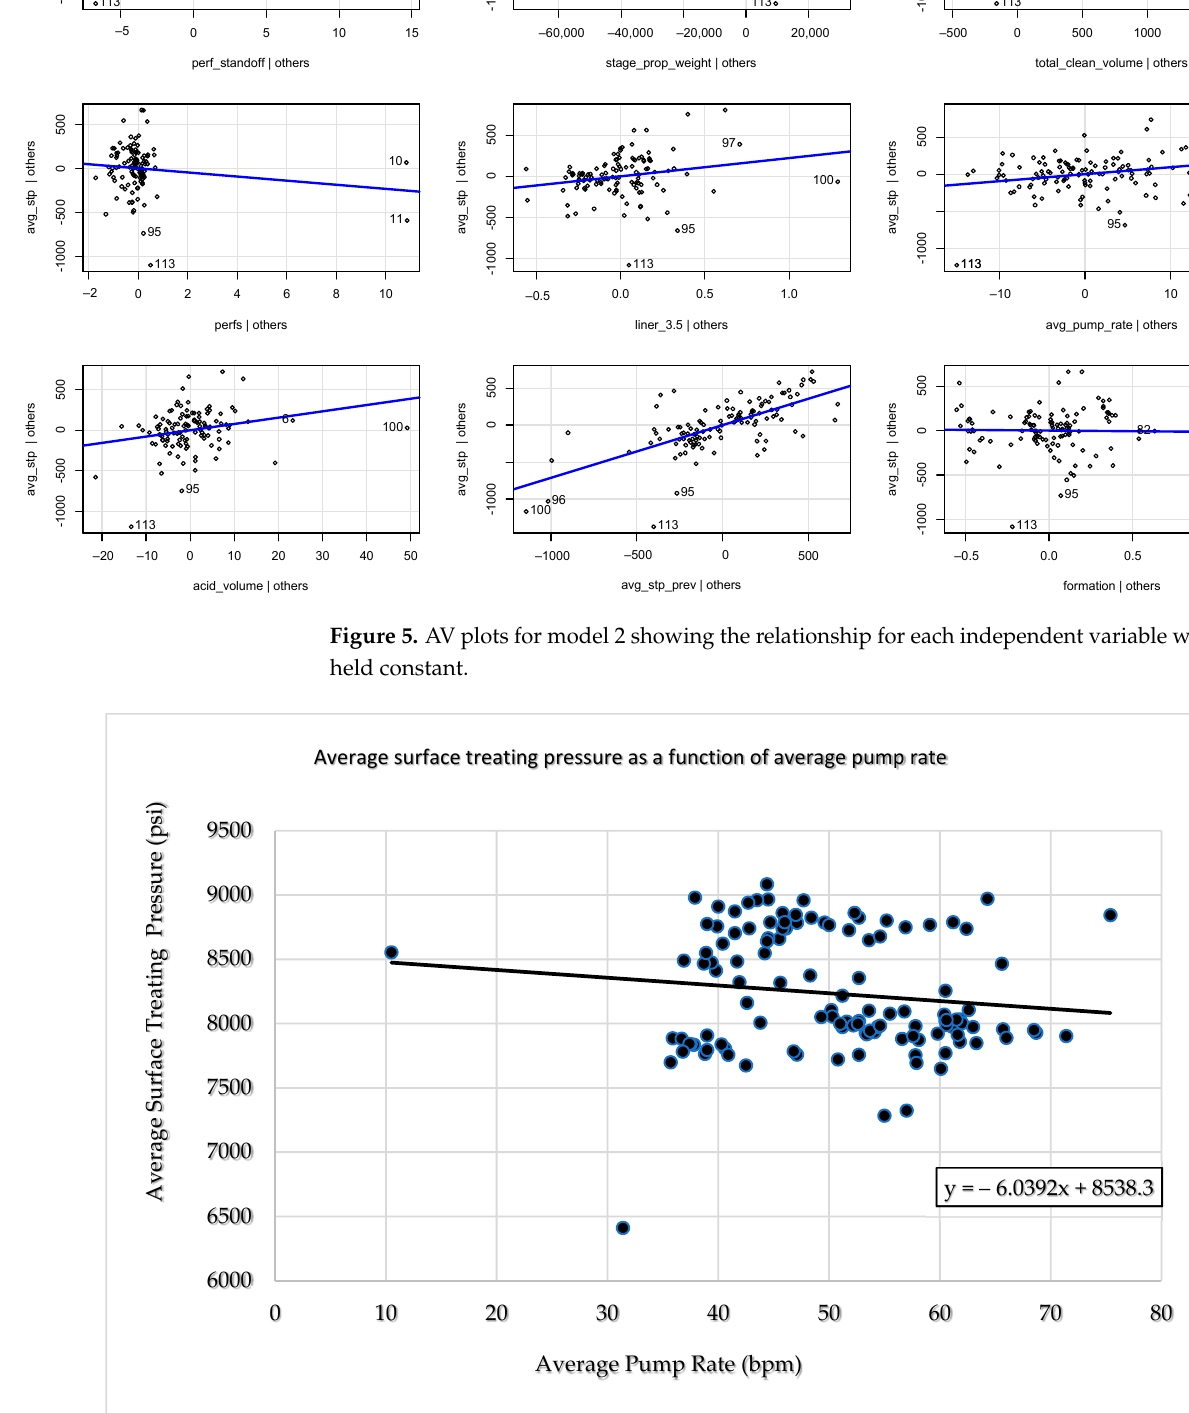
Average Pump Rate (bpm)